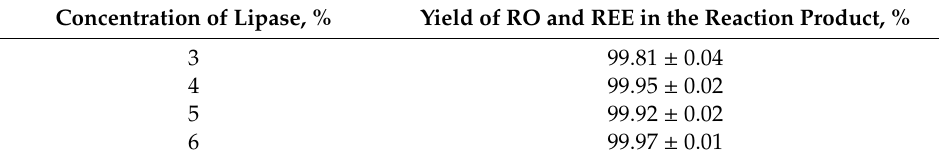
Table 3. The dependence of the yield of rapeseed oil (RO) and rapeseed ethyl esters (REEs) in the reaction product on the lipase (Lipozyme TL IM) concentration when the mineral diesel and rapeseed oil blend ratio is 9:1 (w / w), the oil-to-ethanol molar ratio is 1:5, the duration of reaction is 7 h and the temperature of reaction is 30 ◦